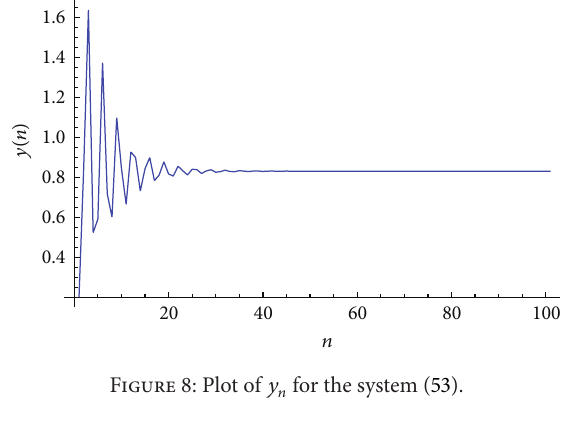
Figure 6: An attractor of the system (52).